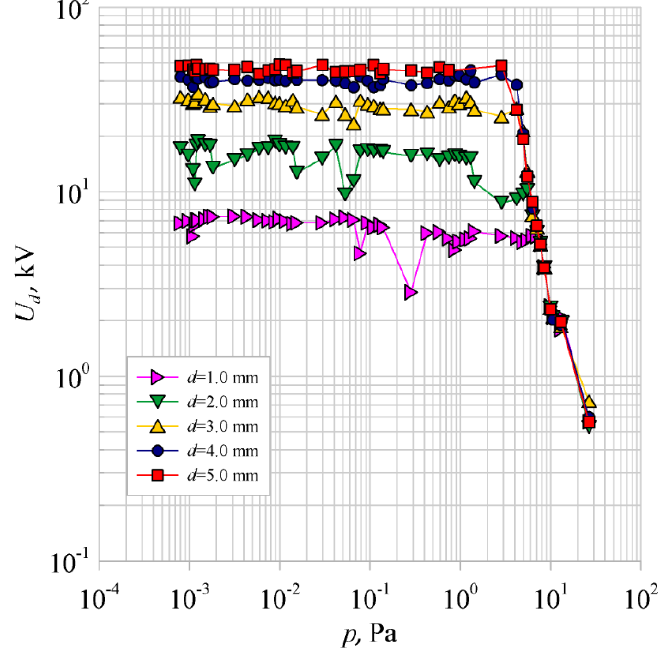
Figure 4. Dielectric strength of the vacuum chamber for different contact distances [18,53].